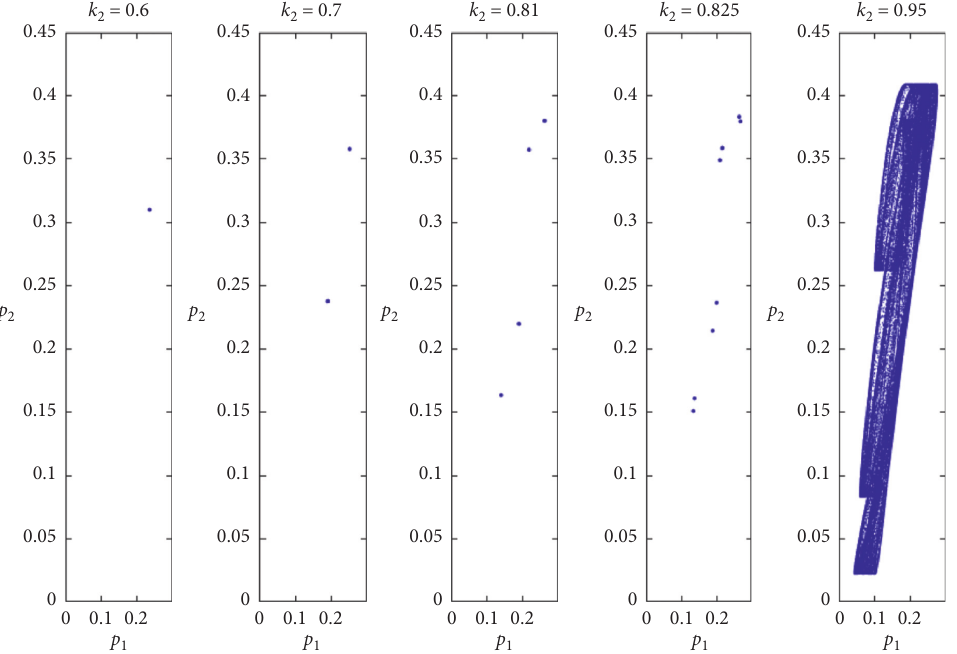
Figure 6: Phase portraits for Figure 5 with various values of k